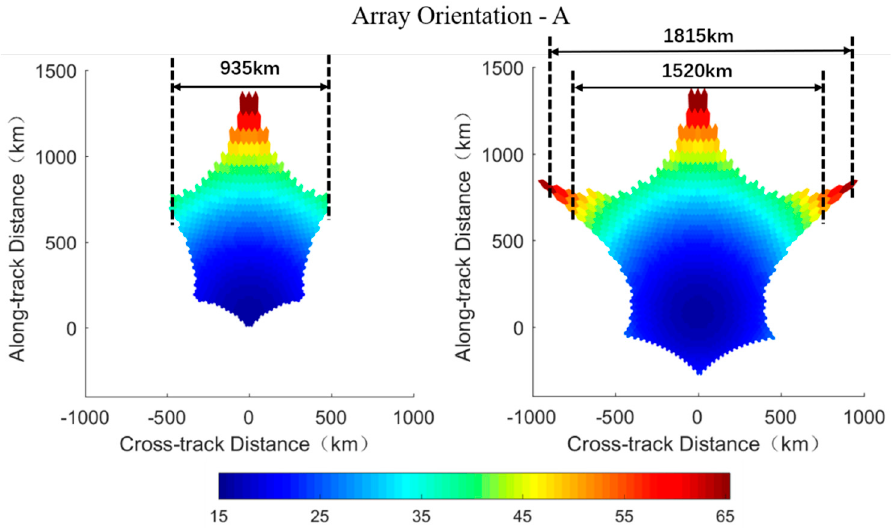
Figure 7. Illustration of the ground spatial resolution distributions of the array orientation A. The distributions in the AF-FOV and EAF-FOV are shown in the left and right panels, respectively, and the corresponding swath widths are labeled in each subplot. The color bar represents for the square root of each pixel’s area in km.